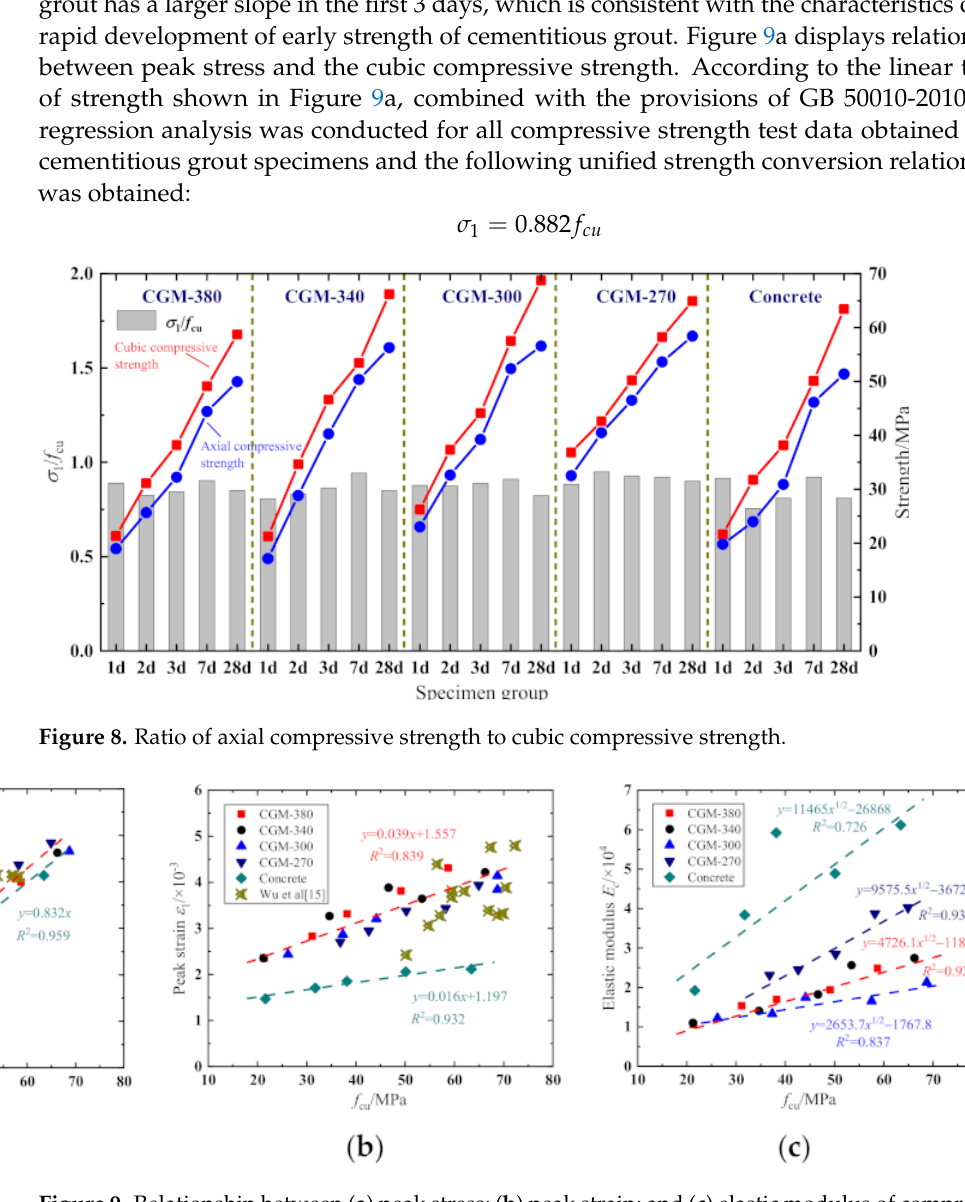
Figure 9. Relationship between ( a ) peak stress; ( b ) peak strain; and ( c ) elastic modulus of compressive stress–strain curve and cubic compressive